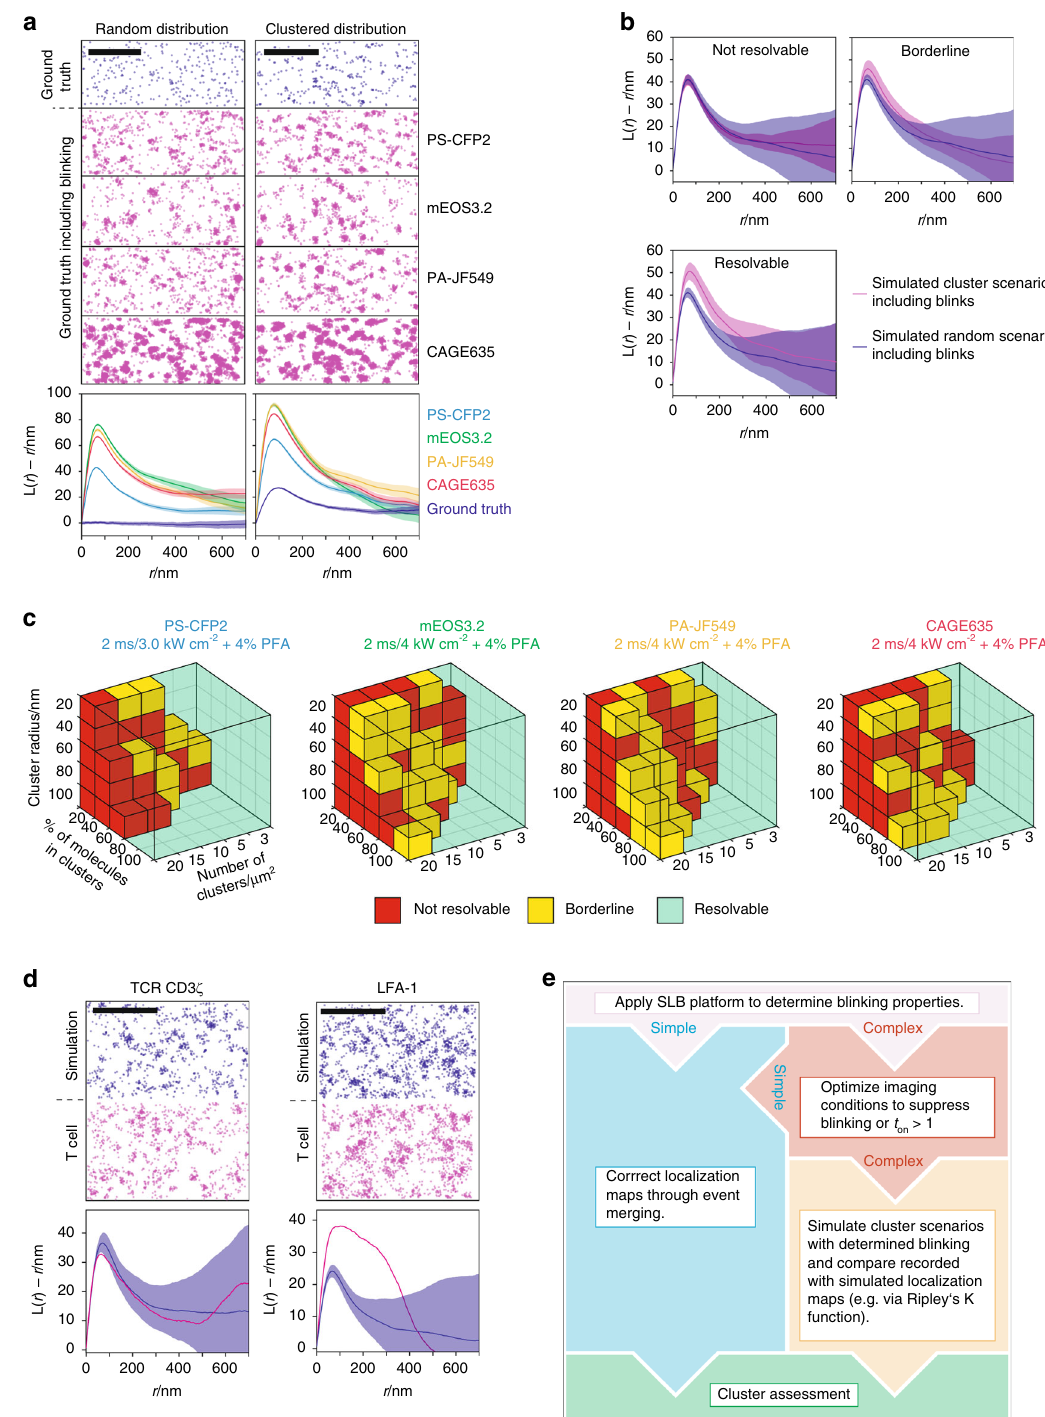
random distribution. When implementing fl uorophore-speci fi c blinking, the normalized Ripley ’ s K function resulted in a distinct peak indicating clusters of localizations. We next compared real protein clusters with their corresponding localization map as it manifested with fl uorophore-speci fi c blinking. Both scenarios feature clearly discernible clusters affecting Ripley ’ s K function (Fig. 3a, lower right panel). Importantly, based on Ripley ’ s K analysis the random distribution of blinking fl uorophores (Fig. 3a, lower left panel) could not be discriminated from a clustered distribution of both non-blinking and blinking